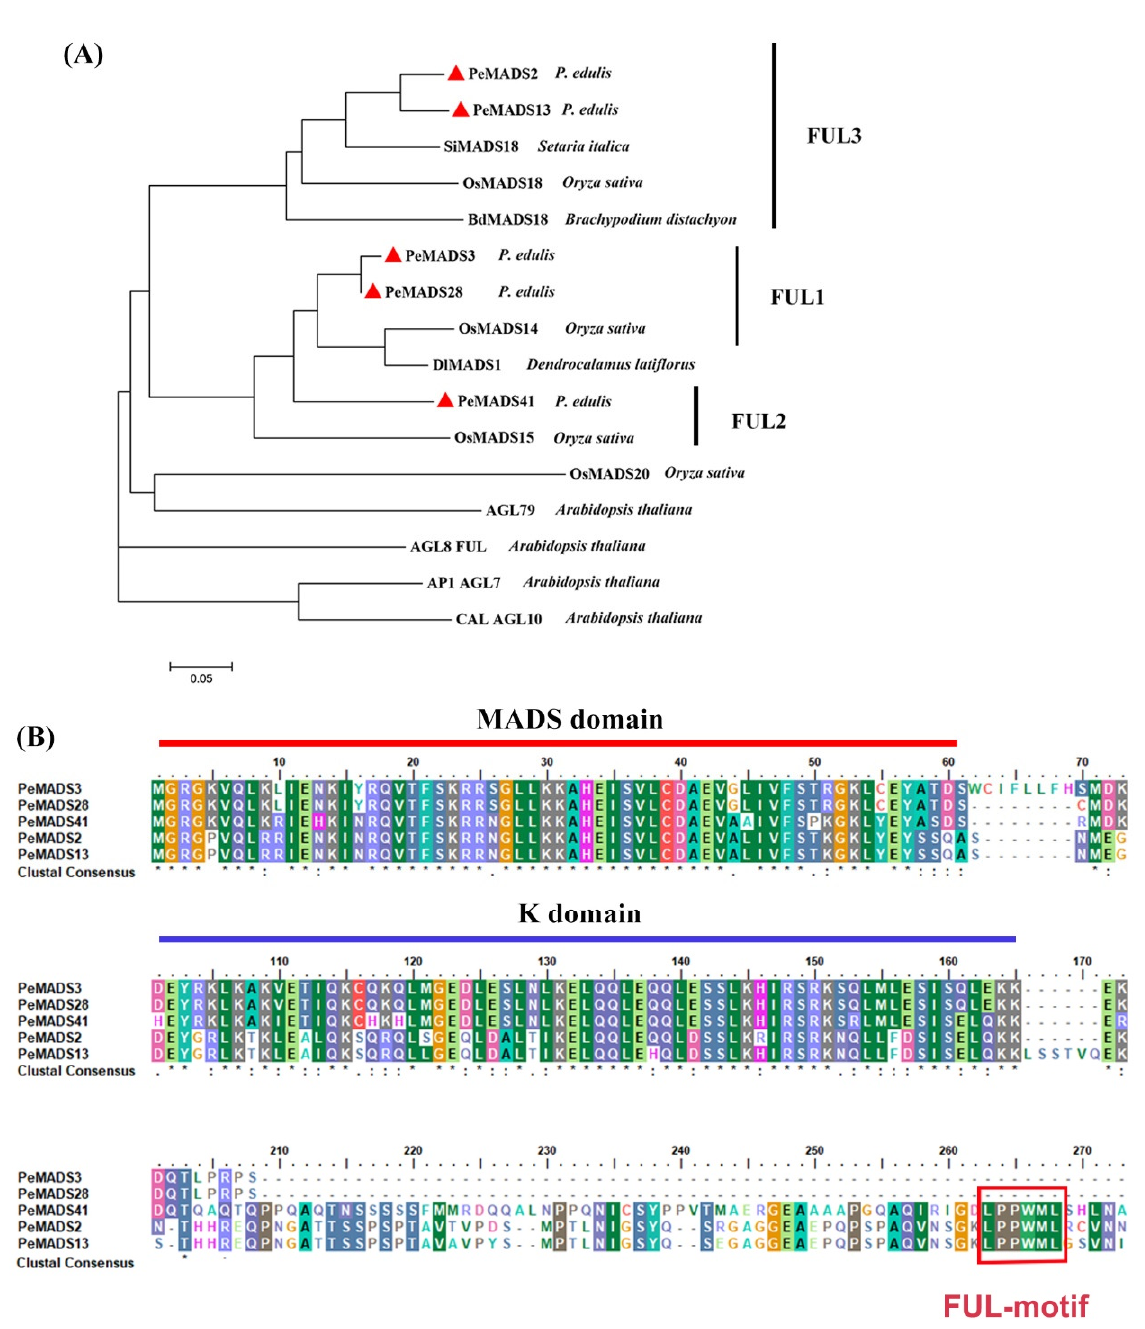
Figure 1. Sequence analyses of PeSQUA-like. ( A ) A phylogenetic tree of Moso bamboo PeSQUA-like and SQUA-like proteins from other species. The phylogenetic tree was constructed with the neighbor-joining (NJ) method and evaluated by bootstrap analysis using MEGA soft (version 7.0). Sixteen SQUA-like proteins were used: four from A. thaliana (AGL7, AGL9, AGL10, and AGL79), four from rice (OsMADS14, OsMADS15, OsMADS18 and OsMADS20), one from Brachypodium distachyon (BdMADS18), one from Setaria italic (SiMADS18), and one from D. latiflorus (DlMADS1). P. edulis SQUA-like proteins are marked by red triangles. ( B ) Alignment of AA sequences of P. edulis SQUA-like proteins. The lined regions represent the conserved MADS domain and K domain. The red boxed region in the C-terminal represents the FUL-like motif. Residues that are identical in all sequences in the alignment are marked with “*” in the bottom row, conserved and semi-conserved substitutions with “:” and “.” respectively.